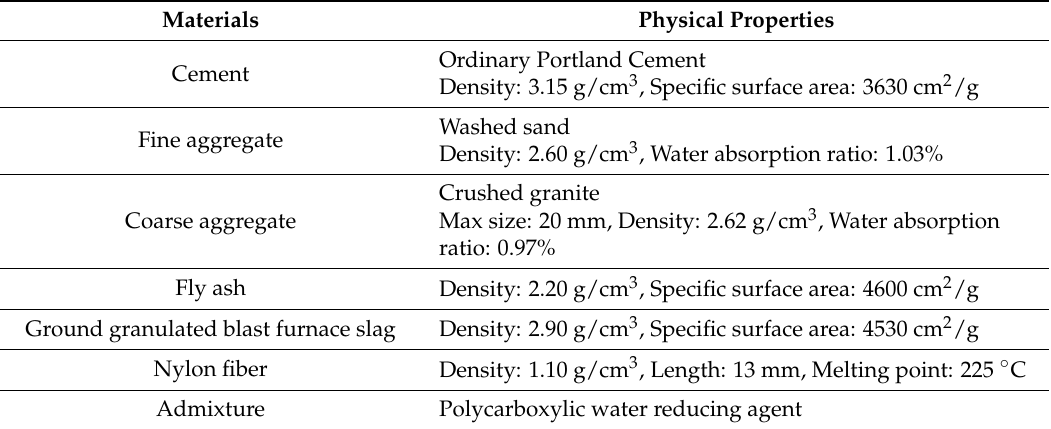
Table 3. Physical properties of the materials.